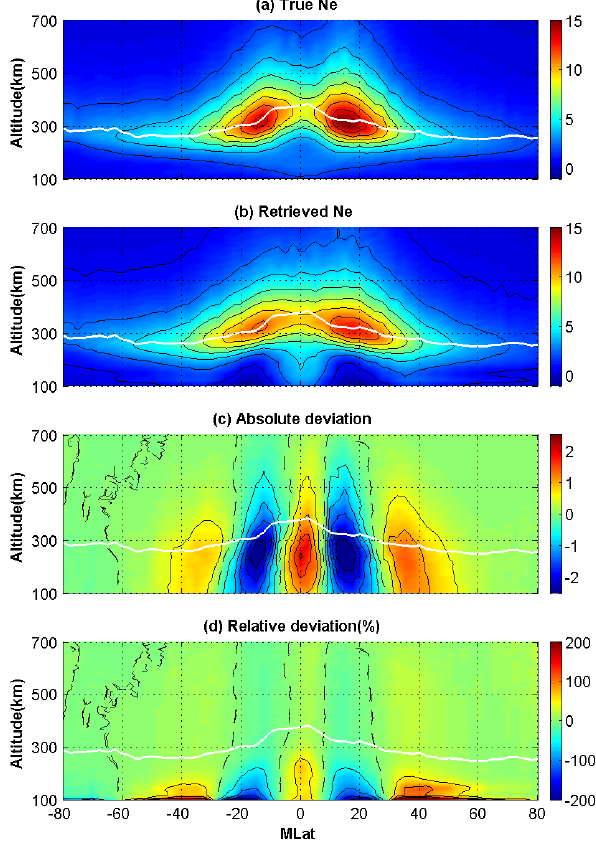
Fig. 2. Geomagnetic latitudinal and altitudinal variations of true electron density (a) , retrieved electron density (b) , absolute devia- tion (c) and relative deviation (d) between retrieved and true elec- tron density during 12:00–14:00LT. The white lines indicate the hm F2 of true electron density. The unit in panels (a–c) is 10 11 m − 3 and in panel (d) is percentage. The dashed lines in panels (c) and (d) indicate zero values. The intervals between the contour lines in (c) and (d) are 0.5 × 10 11 m − 3 and 50%,